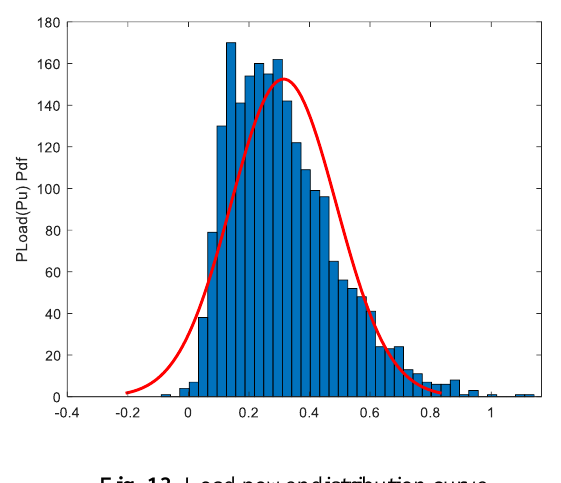
Fig. 13. Load power distribution curve